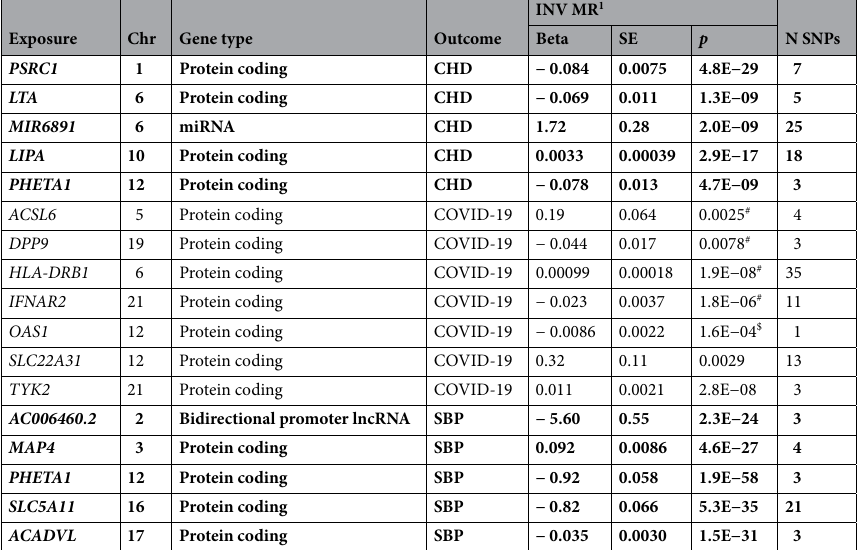
tions. For example, the top two Biological Processes are “leukocyte degranulation” (FDR = 1e−6) and “myeloid leukocyte mediated immunity” (FDR = 2e−6) and the top two Cellular Components are cytoplasm (FDR = 3e−6) and MHC protein complex (FDR = 6e−6). The top 1000 top trans -eGenes gave rise to 75 significant (FDR < 0.05) GO terms including 37 for Biological Process, 32 for Cellular Component, and 6 for Molecular Function. The top GO terms for the top 1000 trans -eGenes were enriched in pathways and molecular functions related to immune functions (Supplemental Table 7).